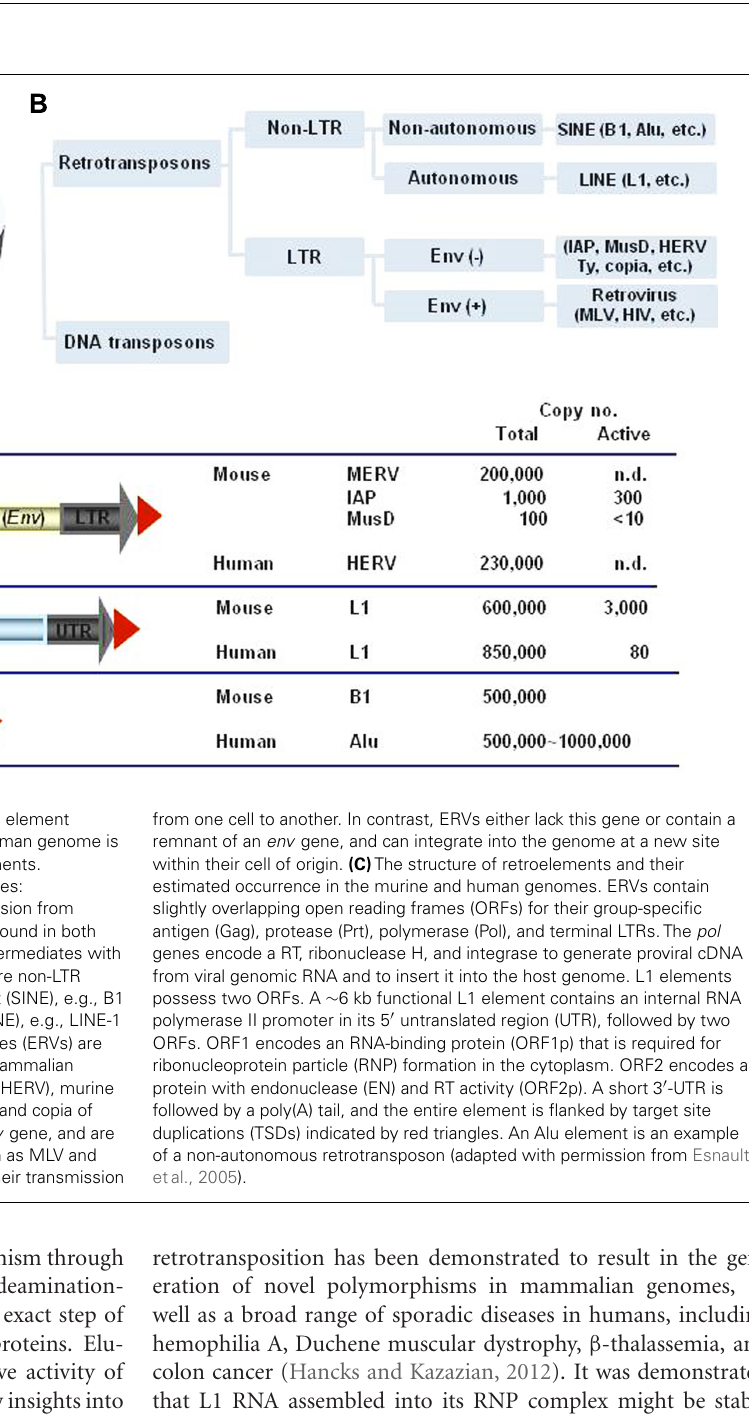
FIGURE 1 |The transposable element. (A) The transposable element content of the human genome. Approximately 45% of the human genome is currently recognized as being derived from transposable elements. Transposable elements can be separated into two major classes: retrotransposons and DNA transposons (adapted with permission from Cordaux and Batzer, 2009). (B) Retrotransposons, which are found in both eukaryotes and prokaryotes, move into genomes via RNA intermediates with reverse transcriptase (RT).The majority of retrotransposons are non-LTR retrotransposons, such as short interspersed nuclear element (SINE), e.g., B1 and Alu elements, and long interspersed nuclear element (LINE), e.g., LINE-1 (L1). LTR retrotransposons, also called endogenous retroviruses (ERVs) are multicopy retroelements accounting for around 10% of the mammalian genome. Examples of LTR retrotransposons are human ERV (HERV), murine IAP, MusD, variousTy elements of Saccharomyces cerevisiae and copia of Drosophila . LTR retrotransposons usually lack a functional env gene, and are structurally similar to mammalian infectious retroviruses, such as MLV and HIV, which encode an envelope protein (Env) that facilitates their transmission